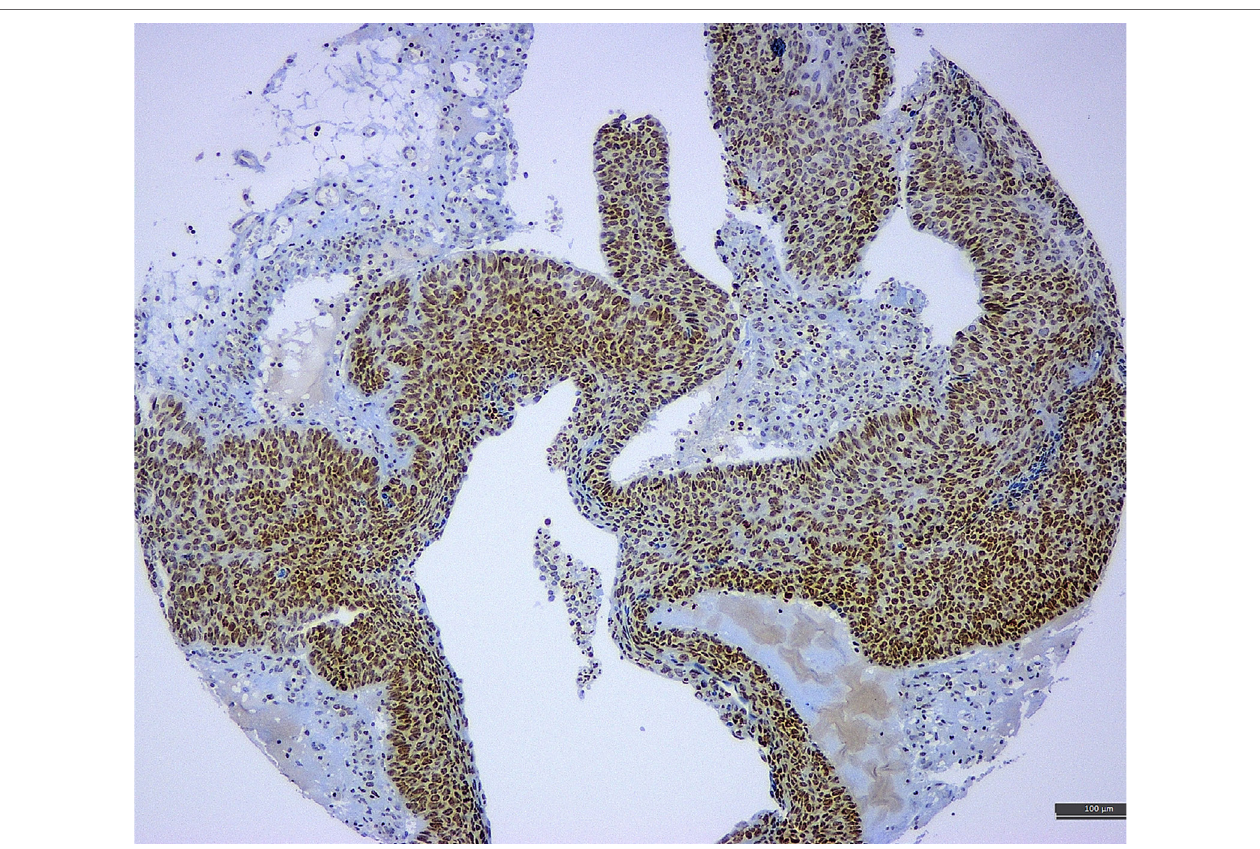
FigURe 2 | A tissue microarray sample of cervical cancer associated with CIN3 lesion exhibiting strong positivity for Epstein–Barr virus (latent membrane protein 1 antibody) (immunohistochemistry, 10 ×